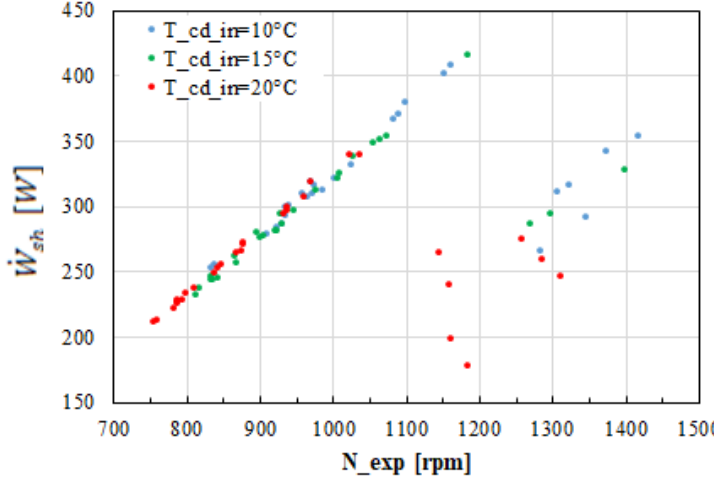
Figure 25. The expander shaft work with the expander shaft speed colored according to the cold fluid inlet temperature in the condenser.